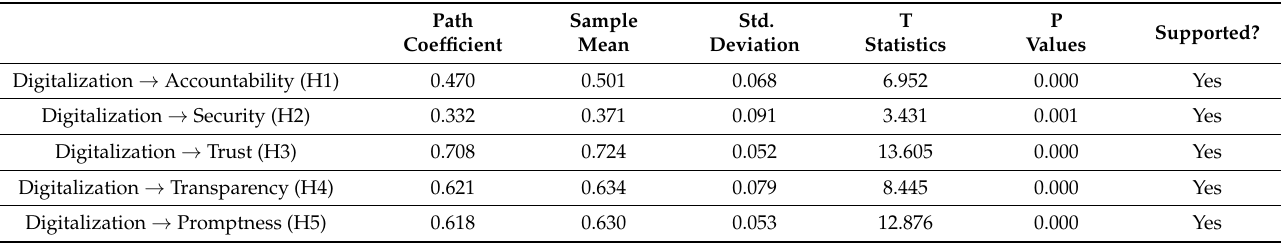
Table 4. Path analysis using bootstrapping.